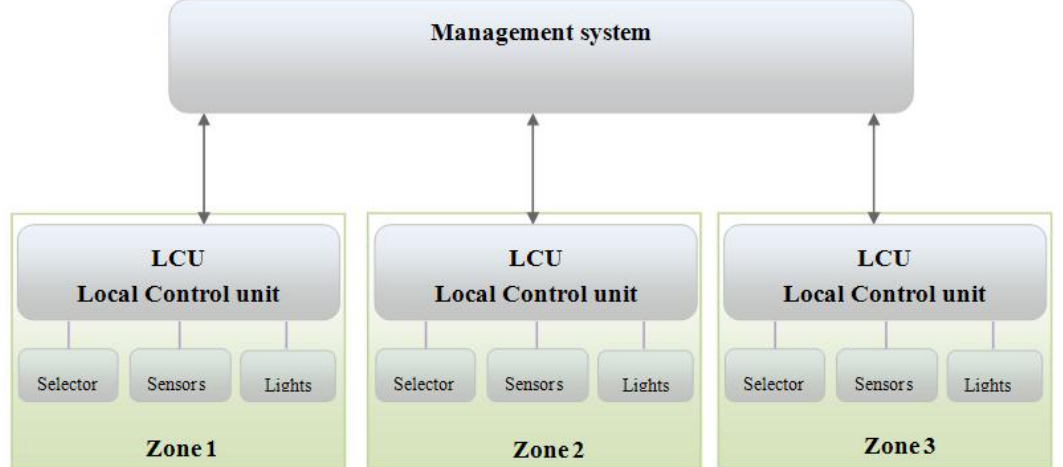
Figure 1. Lighting Automatic Control System (LACS) architecture.